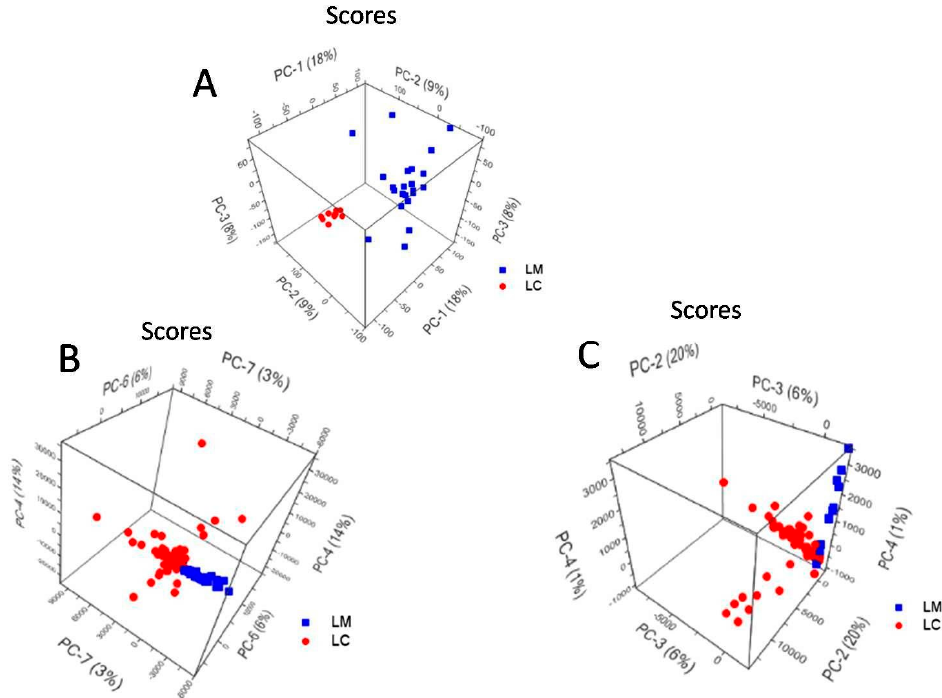
Figure 6. PCA scores plot of ( A ) Raman spectra; ( B ) SERS spectra using a priori prepared Ag colloid and ( C ) SERS spectra obtained using in situ prepared Ag colloid, showing the grouping of L. monocytogenes (LM) and L. casei (LC).